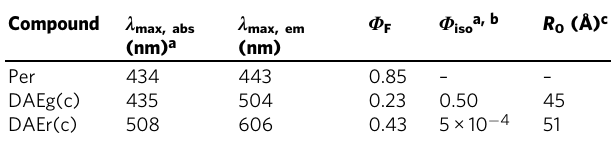
Table 1 Photophysical properties of the studied